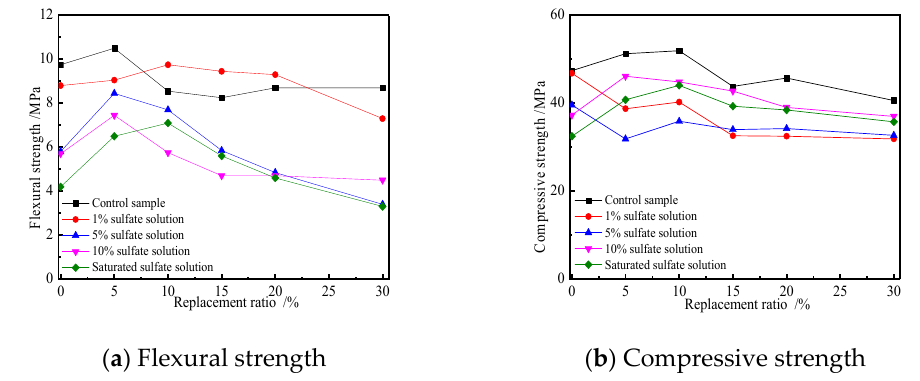
Figure 7. Variation curves of the strength of the mortar with slag content.